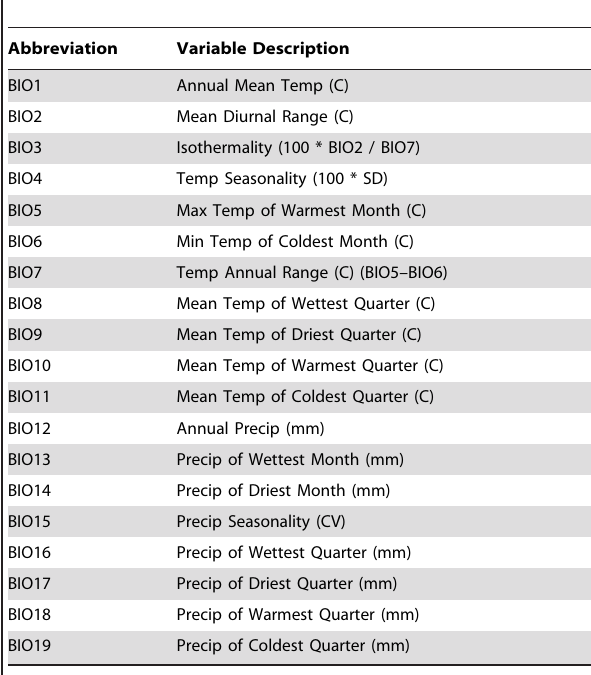
Table 1. Nineteen bioclimatic variables derived from the WorldClim